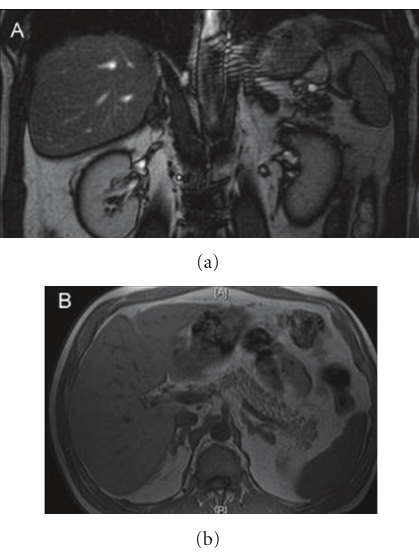
Figure 1: Magnetic resonance imaging of the upper abdomen showing asymmetric, bilateral enlargement of the adrenal glands.